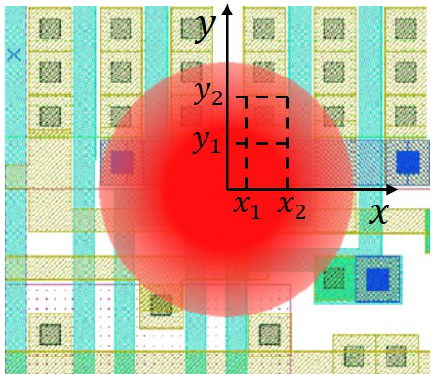
Figure 3. Illustration of the laser spot covering many elementary